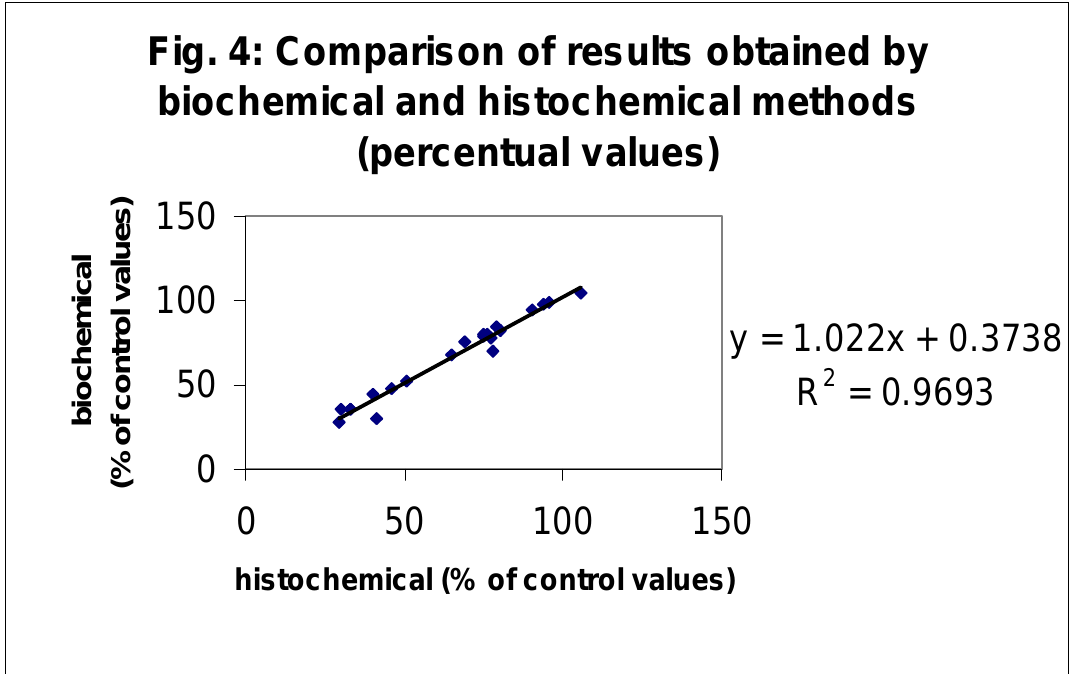
Figure 4. Comparison of results obtained by histochemical and biochemical methods (percentual values) following administration of soman, huperzine and soman pretreated with huperzine. Fig. 4: Comparison of results obtained